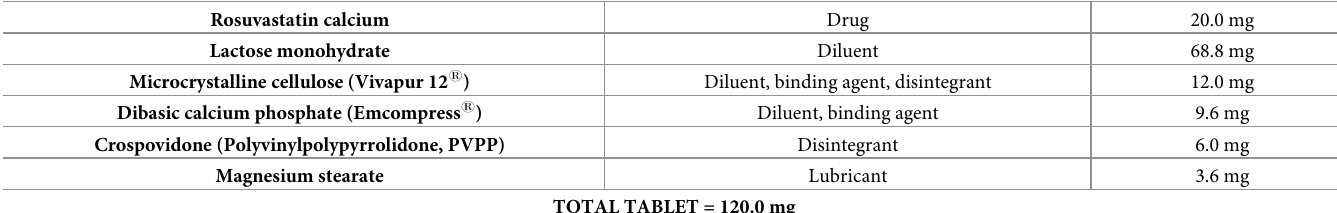
Table 2. Composition of tablet formulation expressed in mg per